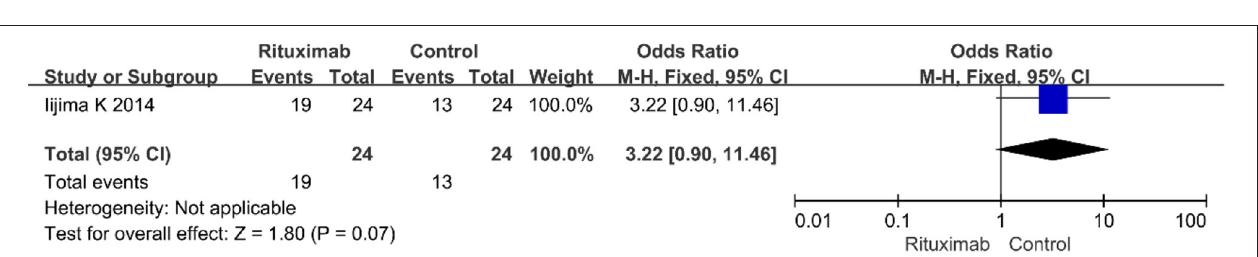
FIGURE 8 | Forest plot showing a meta-analysis of infections between rituximab treatment group and control group.